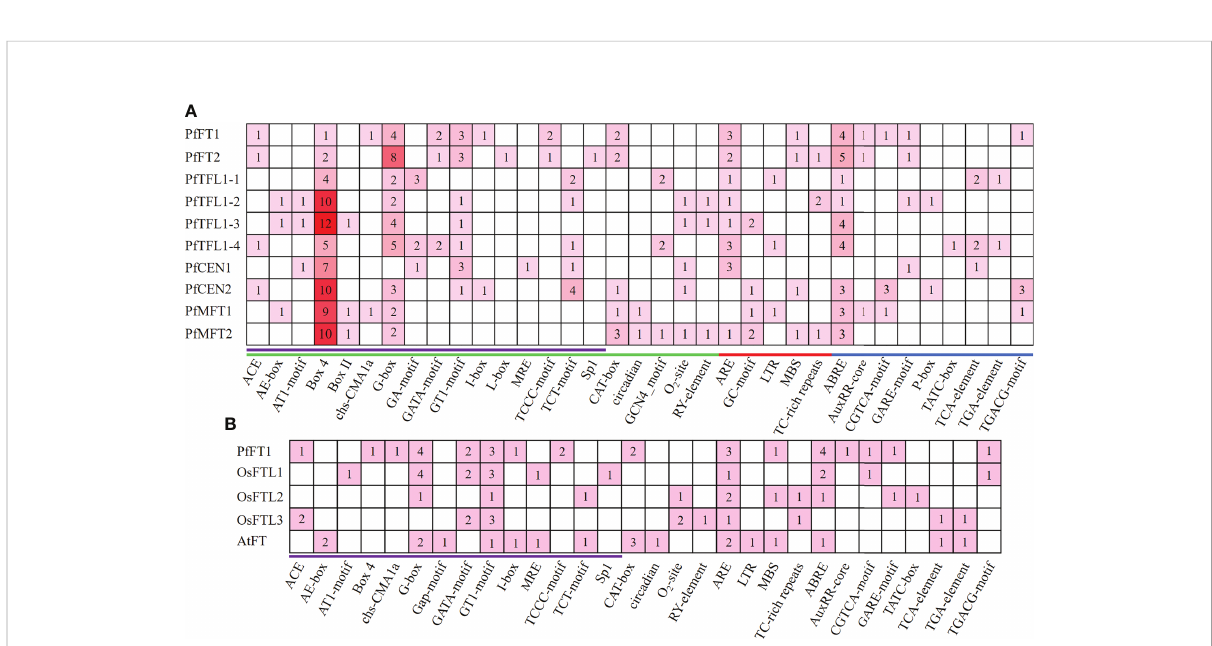
FIGURE 4 Cis -regulatory elements analysis. (A) Cis -regulatory elements analysis was performed in a 2000 bp promoter region of PfPEBP genes. Green, red, and blue lines indicate growth and development, biotic/abiotic stress responses, and hormone responsive element, respectively. Light- response elements were marked in purple. The numbers and colors represent the number of speci fi c cis -acting elements in a gene. The larger the number, the darker the color, and the smaller the number, the lighter the color. (B) Cis -regulatory elements in the promoter region of PfFT1 , OsFTL1 – 3 , AtFT . Light-response elements were marked in